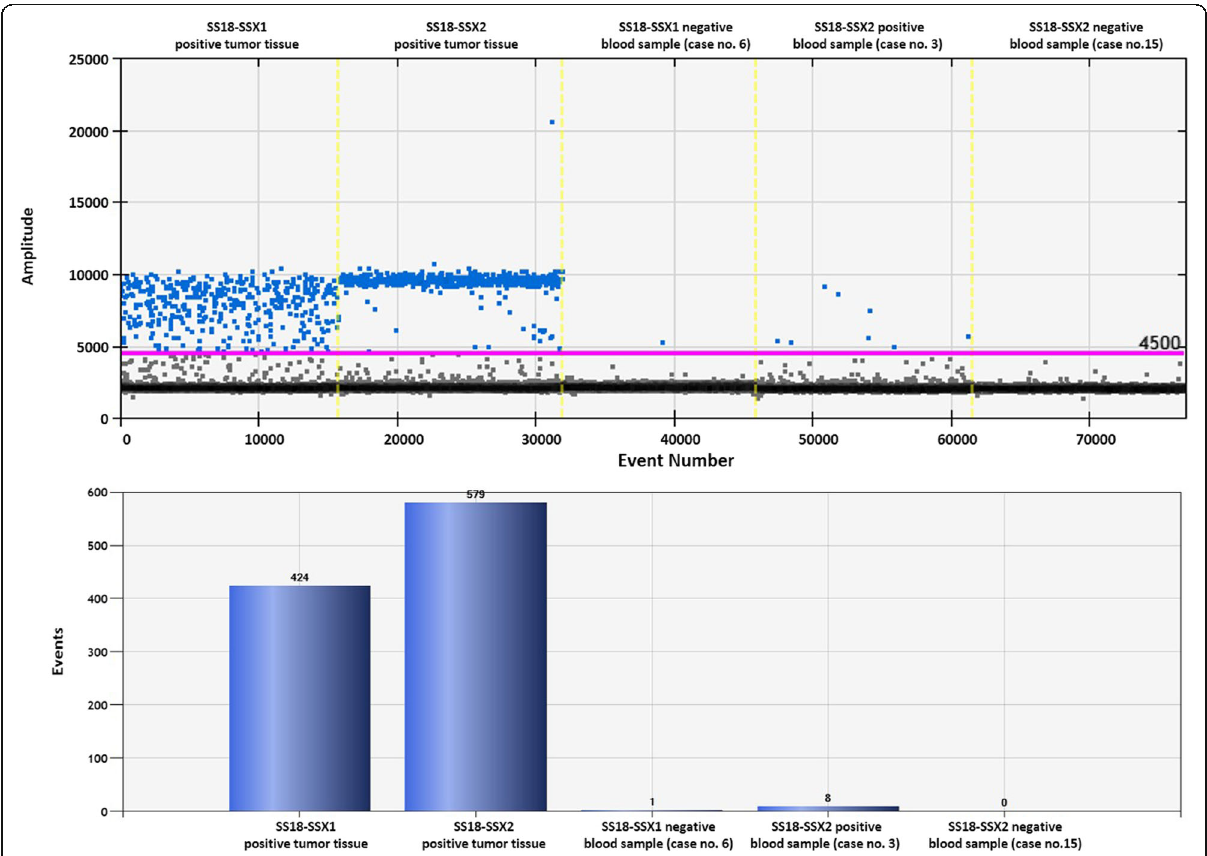
Fig. 3 Result of the droplet digital PCR. The upper panel represents one-dimensional plot of droplets measured for a fluorescence signal emitting from the SS18-SSX1 or SS18-SSX2 positive sample (amplitude is indicated on a vertical axis, while the number of events is indicated on the horizontal axis). Positive droplets are shown in blue. Negative droplets are shown in grey. The lower panel shows the event numbers in column charts of two FFPE tumor samples used as positive controls and three blood samples (case 6, 3 and 15). In case no. 3, we could detect eight events representing the SS18-SSX2 fusion transcript as processed by QuantaSoft ™ (Bio-Rad). Cases no. 6 and 15 were negative to the SS18-SSX1 and SS18-SSX2 fusion